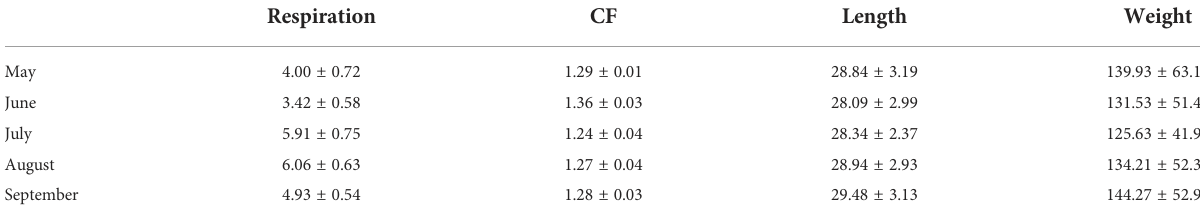
TABLE 4 The mean and standard deviation of krill respiration rate (mg C ind -1 day -1 ), condition factor (CF; WWT (mg) mm -3.44 ), length (mm) and wet weight (mg) from May to September. Respiration CF Length